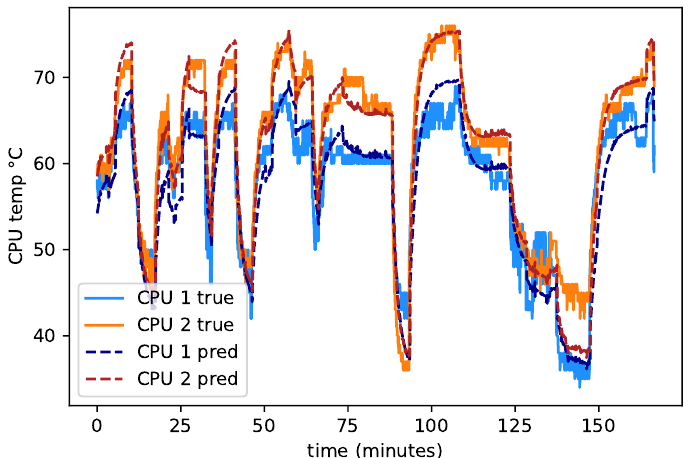
Figure 9. Long-term predictions for CPU temperatures on the test set. The PIDD RNN model was initialized at t=0, and then received only computational load and fan signal experiment sequences.